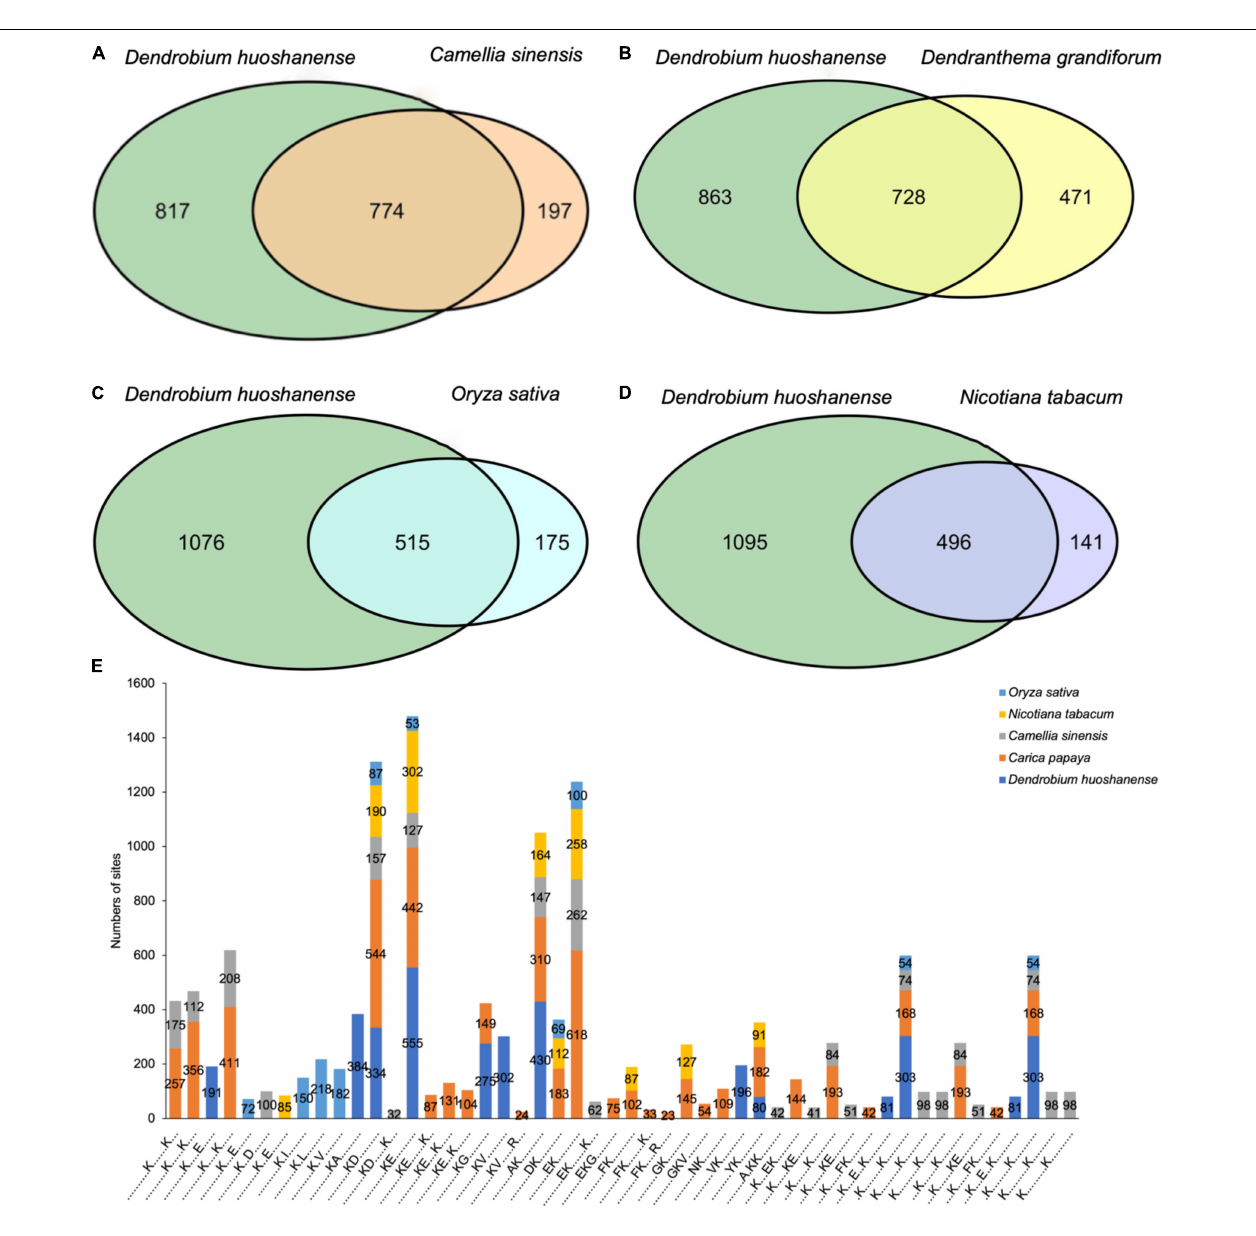
FIGURE 6 | Venn diagrams of the orthologous crotonylated proteins between D. huoshanense and tea (A) , Chrysanthemum (B) , rice (C) , and tobacco (D) . (E) Stacked histogram of crotonylation motifs of D. huoshanense compared with other species.